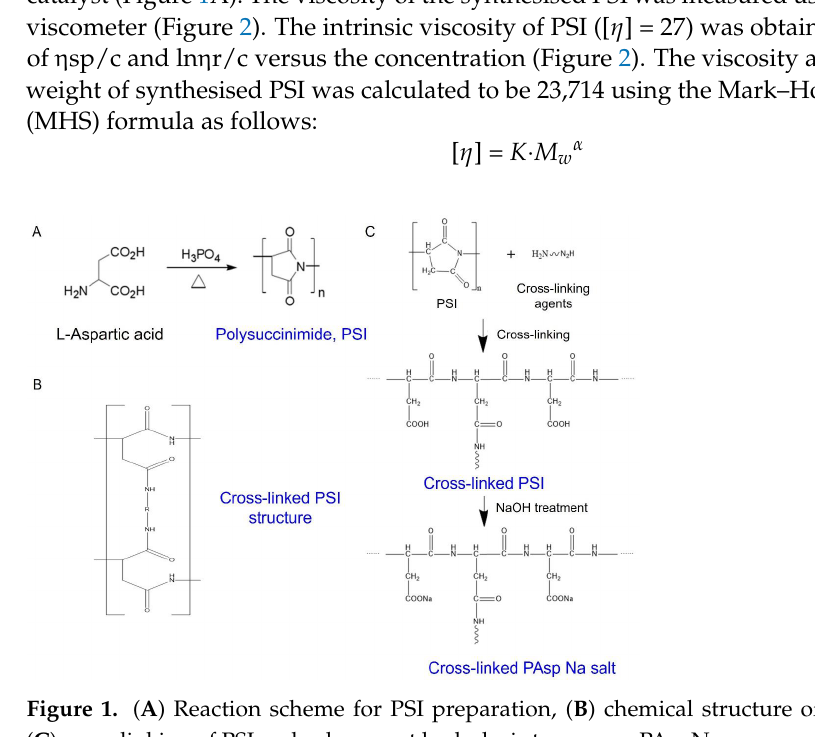
Figure 2. Inherent and reduced viscosity of polysuccinimide measured in DMF (0.1 M LiCl) at 25 °C (average values of three measurements).